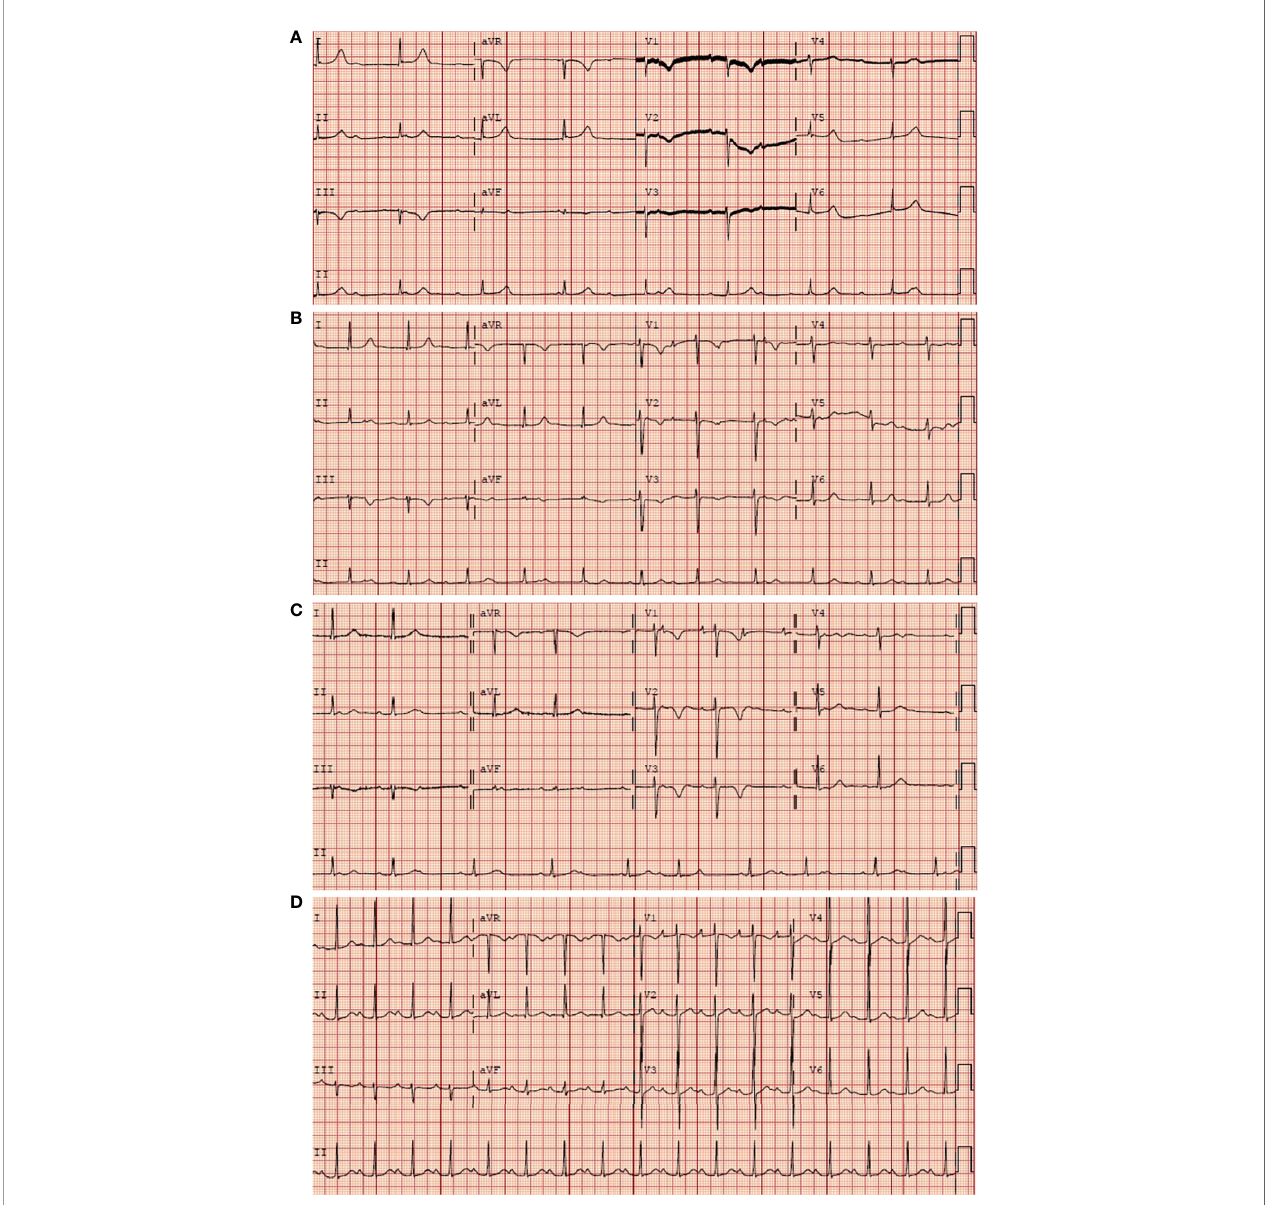
FIGURE 1 | Serial electrocardiographic strips upon patient admission. (A) Complete AVB before chemotherapy. (B) Still complete AVB on the second day after chemotherapy. (C) The complete AVB converted to second degree type 2 AVB on the sixth day after chemotherapy. (D) A fi rst degree AVB on the eighteenth day. The initial electrocardiogram (ECG) of the patient during the